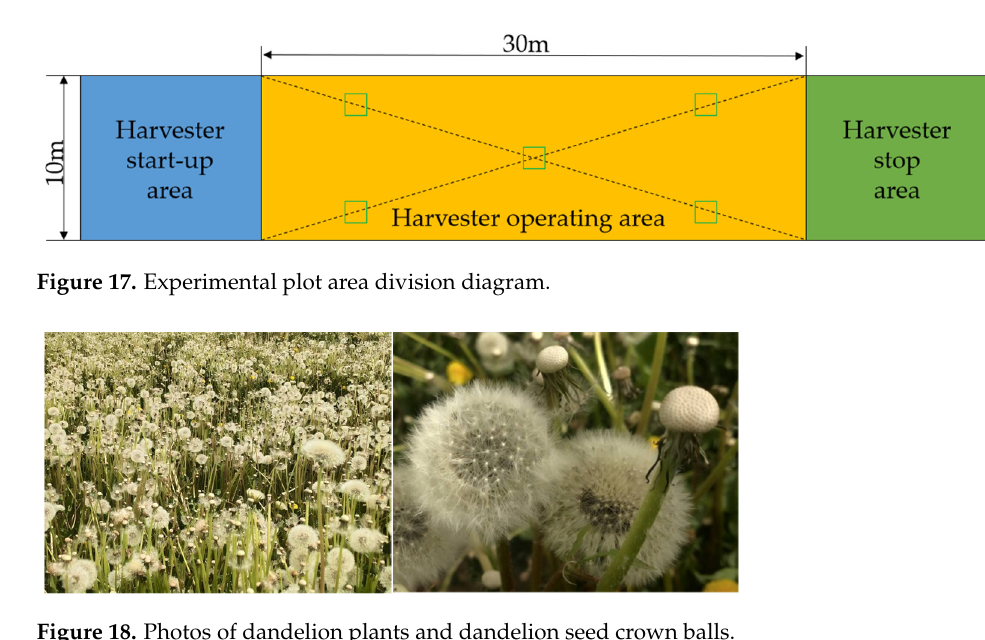
Figure 16. Schematic diagram of sieve arrangement.